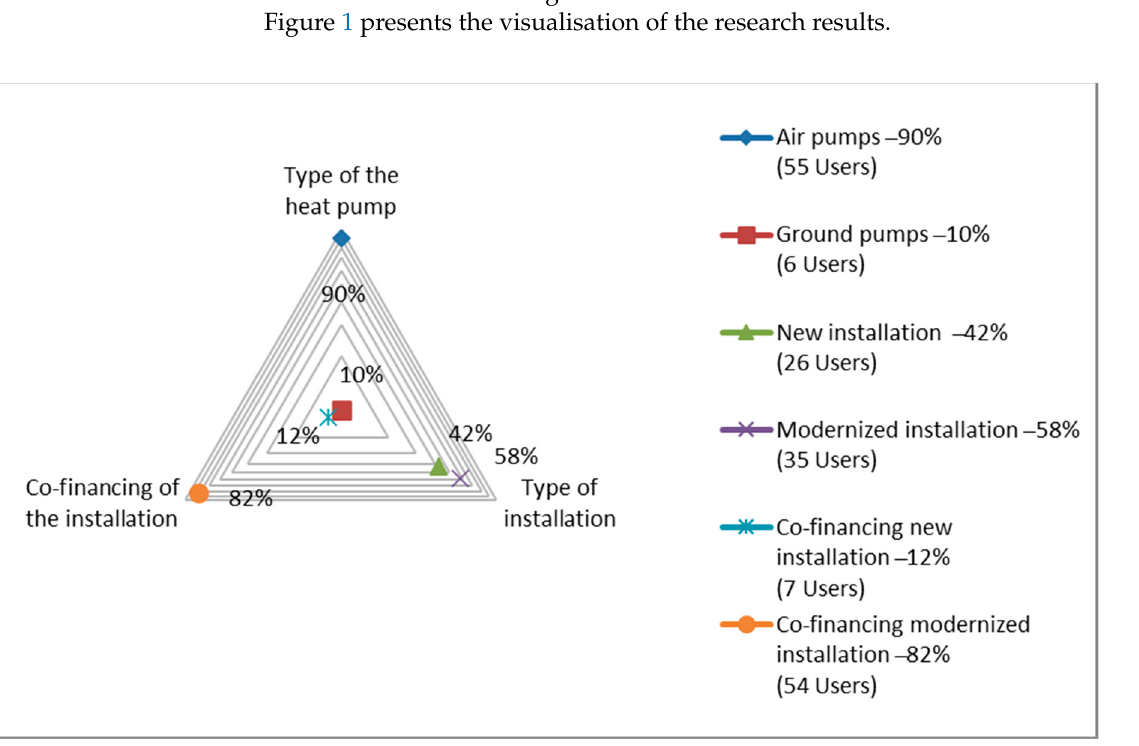
Figure 1. Analysis of heat pump installations—the results of research.